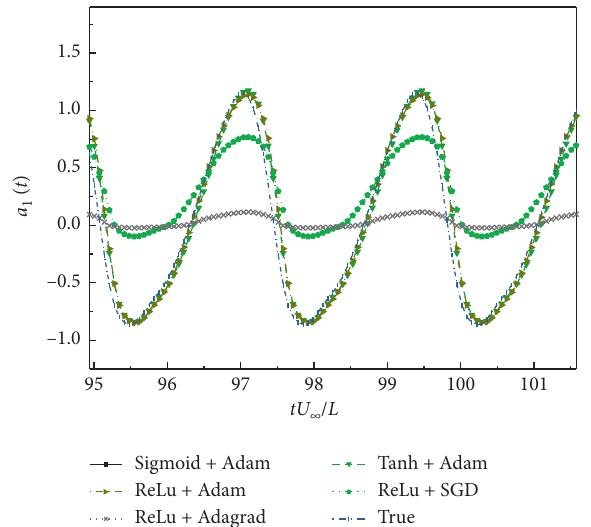
Figure 2: Comparisons of the activation functions and optimizers.